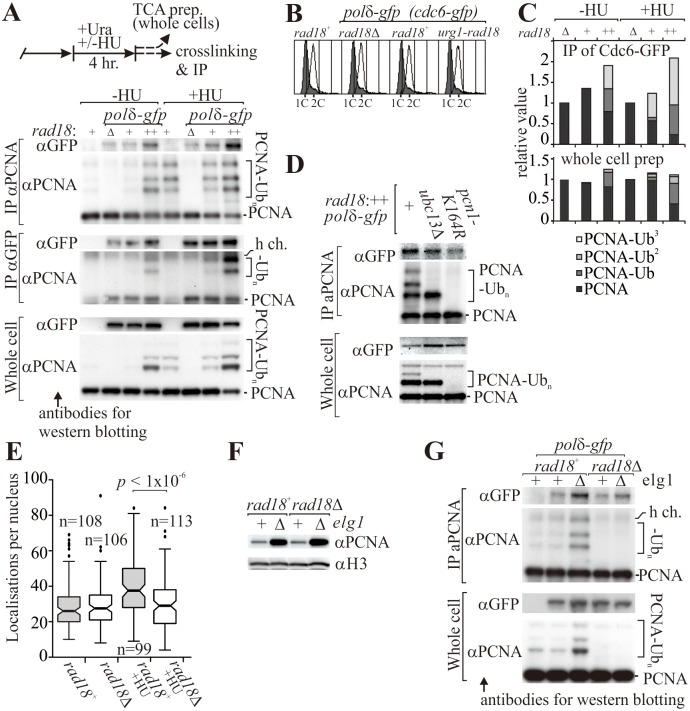
PCNA ubiquitylation contributes to the interaction of Polδ with the clamp.(A) Assessing co-immunoprecipitation of Polδ and PCNA. Top: experimental scheme for co-immunoprecipitation experiments. Cells were either treated, or not, with hydroxyurea (HU) and TCA extracts prepared to monitor PCNA modification (whole cell) or soluble extracts prepared for immunoprecipitation with either anti-PCNA or anti-GFP (the catalytic subunit of Polδ is GFP tagged). Bottom: comparison of the Polδ - PCNA interaction in rad18Δ (Δ), wild-type (+) or urg1-rad18 cells (++) cells that exhibiting distinct levels of PCNA ubiquitylation (see Fig 2A). (B) Cell-cycle profiles. Open histograms -HU, grey histograms +HU. (C) Quantification of modified forms of PCNA that was co-immunoprecipitated with Polδ (“IP with αGFP” in a) and in whole cell extracts. (D) Co-immunoprecipitation of Polδ in Purg1-rad18 cells is partially dependent on ubc13. (E) Quantification of DNA-associated Polδ by single molecule PALM imaging (see Fig 2F for details). (F). Increased chromatin association of PCNA in the elg1Δ genetic background. Chromatin was fractionated from the indicated strains and probed for Pcn1 and a histone H3. (G) Co-immunoprecipitation of Polδ with PCNA in elg1+ (+) and elg1Δ (Δ) cells in the rad18+ and rad18Δ genetic backgrounds.